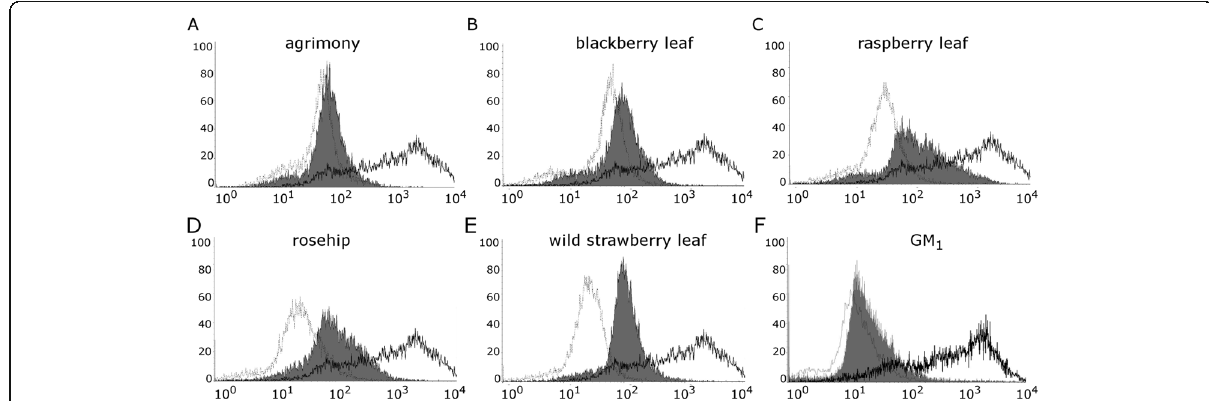
Fig. 5 Plant extract effects on the prevention of binding cholera toxin to cellular receptors. Flow cytometry assay showing the degree of labeled cells C688 after incubation with a mixture of 2.5 mg/mL plant extract and 0.25 μ g/mL FITC-CTB, where the black trace represent cells treated only with CTB-FITC, and grey trace – cells treated only with plant extract and filled grey – cells treated with CTB-FITC and plant extract: a agrimony, b blackberry leaf, c raspberry leaf, d rosehip, e wild strawberry leaf and f GM